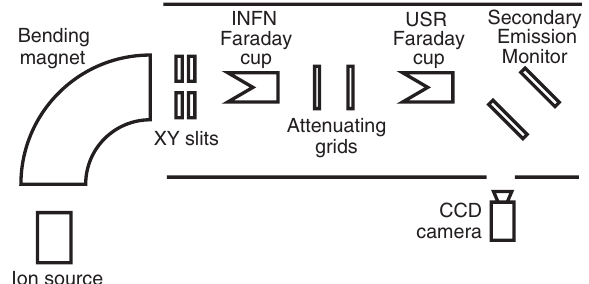
FIG. 7. Experimental setup for the secondary emission moni- tor tests at INFN-LNS.